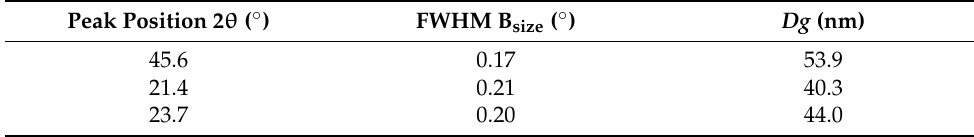
Figure 2. X-ray diffraction pattern of Co 2 MnSi glass-coated microwire measured at room temperature. By using the formula reported in [33], we estimated the nanocrystalline grain size, Dg , related to each peak as listed in Table 1. Table 1. Average grain size (nm) of as-cast Co 2 MnSi glass-coated